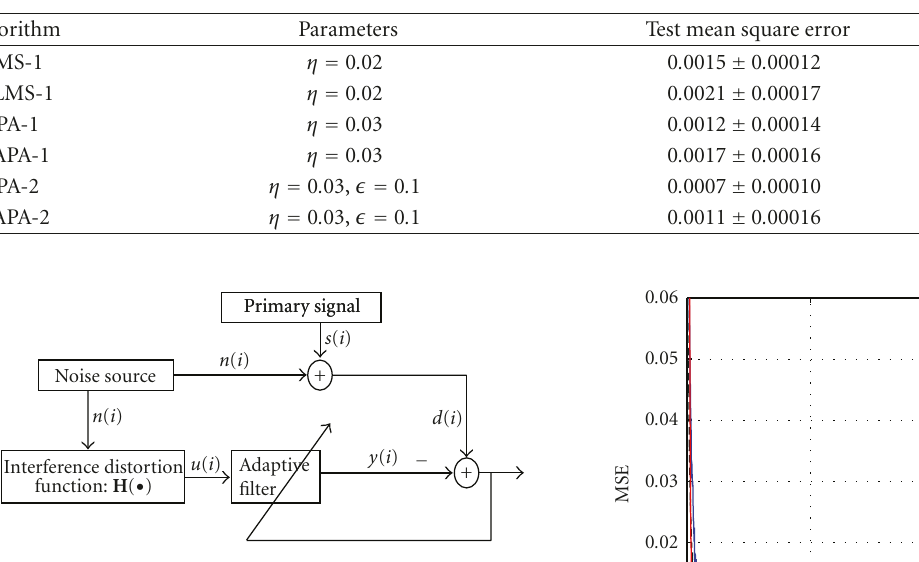
Table 6: Performance comparison in MG time series prediction on novelty criterion.